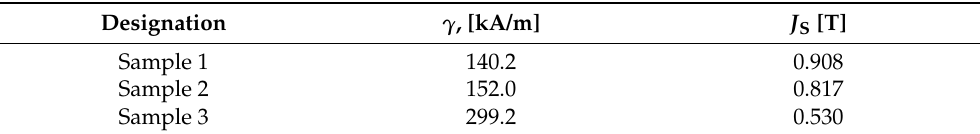
Figure 8. Fitting of anhysteretic curves recovered as the middle curve from loop branches using two fitting parameters γ and J s in the Cohen relationship. Dots—measurement points, lines—modelled curves. Table 4. The estimated values of γ and J s parameters used to model curves presented in Figure